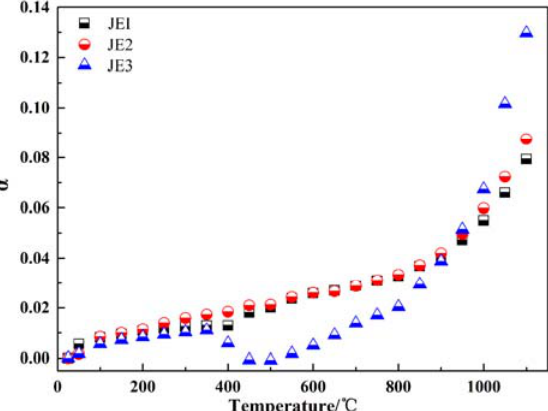
Figure 4. Experimental and calculated values of the coal-iron ore briquettes.